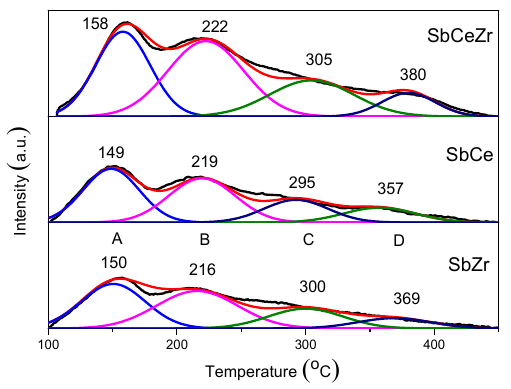
Figure 7. NH 3 -TPD profiles of the catalysts.